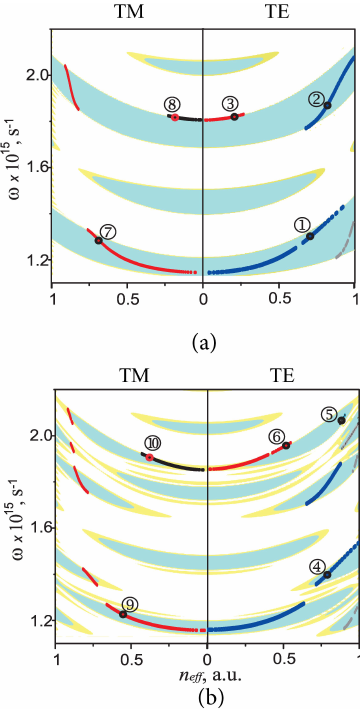
Figure 2: The band diagrams and dispersion curves for TM and TE waves in the Bragg reflection waveguide with (a) periodic cladding and (b) aperiodic cladding. The colored areas correspond to bandgaps with level of reflection | R | > 0.9 . The different colors of the dispersion curves correspond to different values of the mode index m : blue curves correspond to m = 0 , red curves correspond to m = 1 , and black curves correspond to m = 2 . The gray lines represent modes with m = −1 ; N = 24